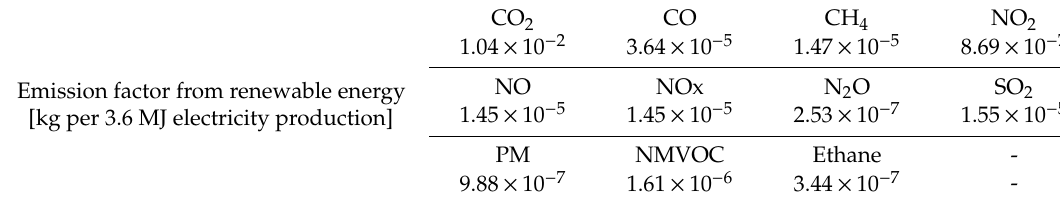
Table A7. Emission factors of renewable energy at the Well-to-Tank phase.